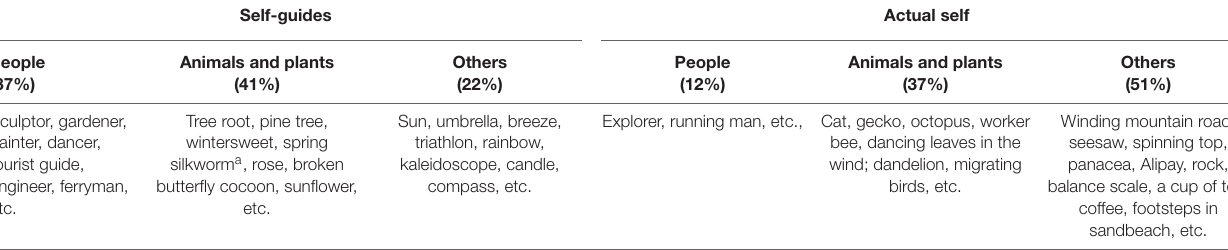
TABLE 4 | Examples of the metaphors provided by the female EFL teachers. Self-guides Actual self People Animals and plants (37%) (41%)